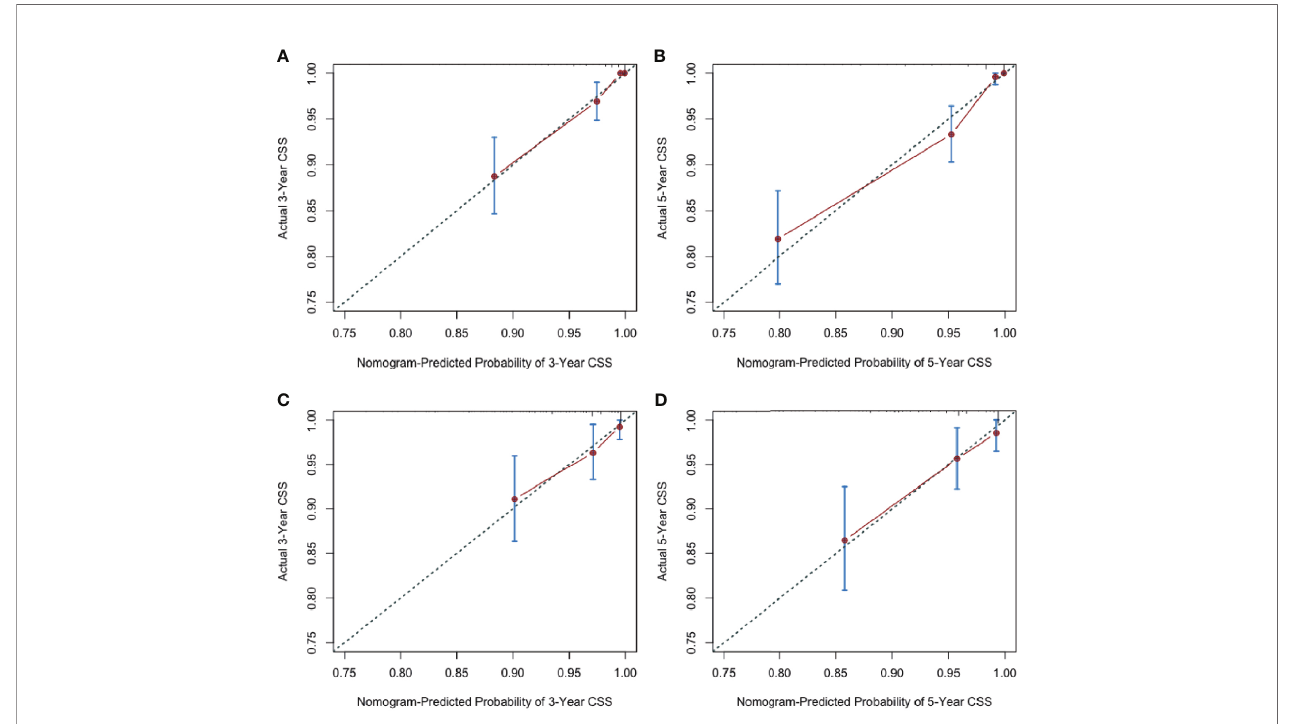
FIGURE 3 | Nomogram calibration curves for predicting cancer-speci fi c survival probabilities (A) at 3 year and (B) 5 years in the training cohort; at 3 year (C) and 5 years (D) in the validation cohort.